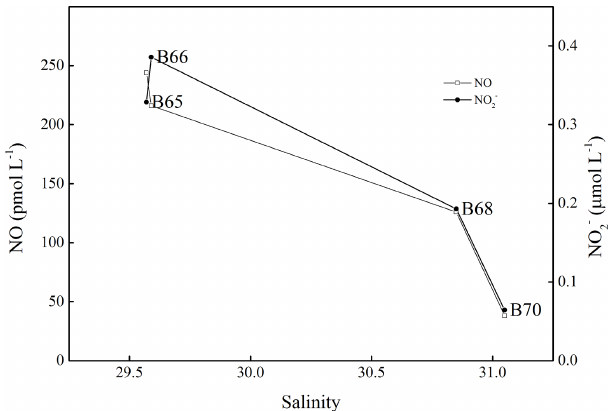
Figure 3. Variations in salinity, NO surface concentrations, and NO − concentrations from station B65 to station B70. 2